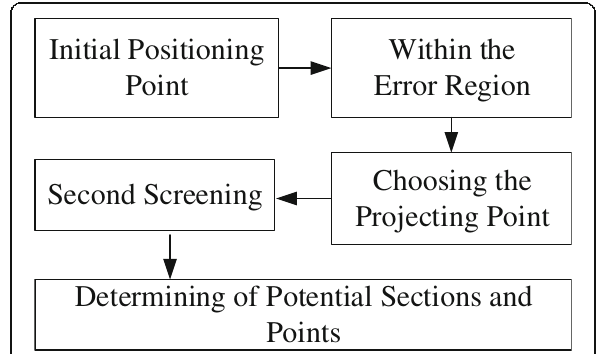
Fig. 4 Determining of potential sections and points